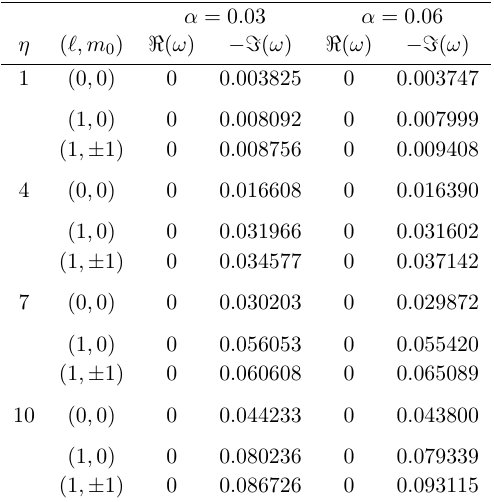
Figure 4 . Scalar field potentials for the ARNAdS black hole with parameters r h = − Λ / 3 = 1 and Q = 0 . 7 (left), Q = 0 . 999 (right) with ‘ = 0 . The regions where V is negative is limited to: a small interval in r ∗ , for large r as displayed in the left panel; a small well in the near-extremal black hole as shown in the right panel; a small interval for large r also in the near-extremal case. This situation does not yield unstable field evolutions in any case. α = 0 . 03 α = 0 . 06